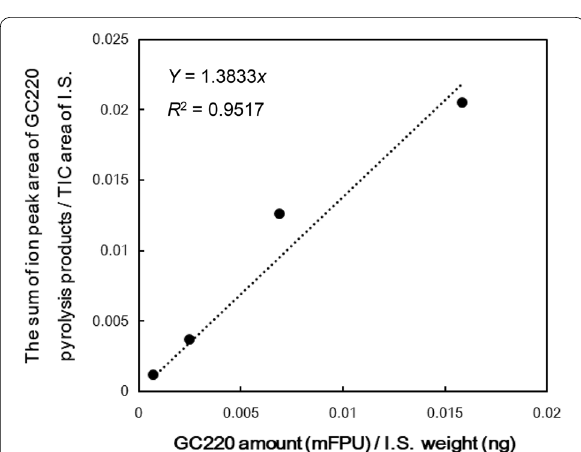
Fig. 4 The calibration curve for quantitation of the GC220 enzyme. Notes: I.S., internal standard, FPU, filter paper